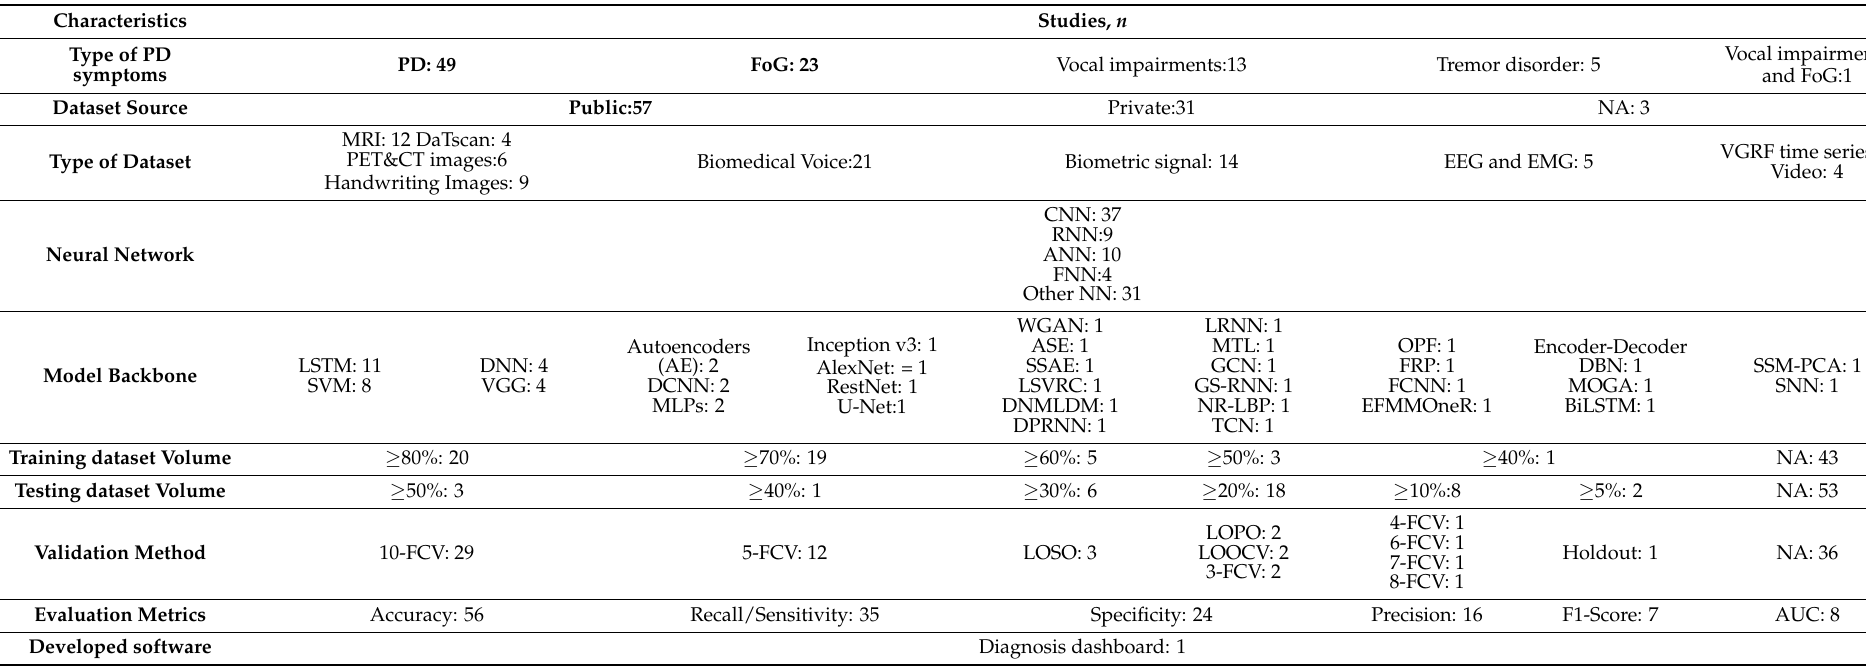
Table 3. Description of PD detection techniques ( n =